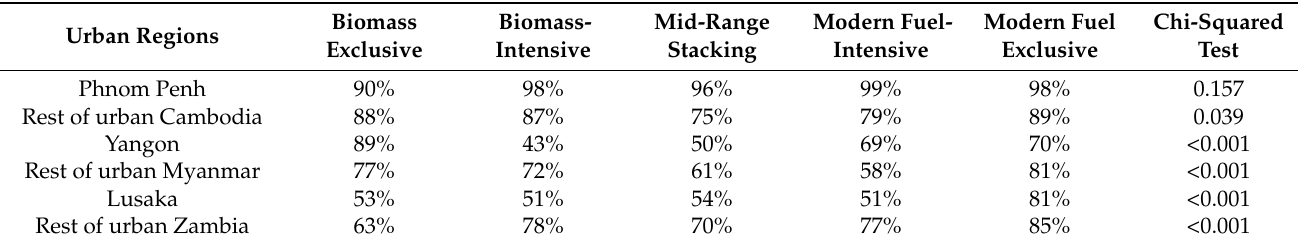
Table 12. Percentage of households that stated the quality of their electricity supply remains constant over the course of a 12-month period.